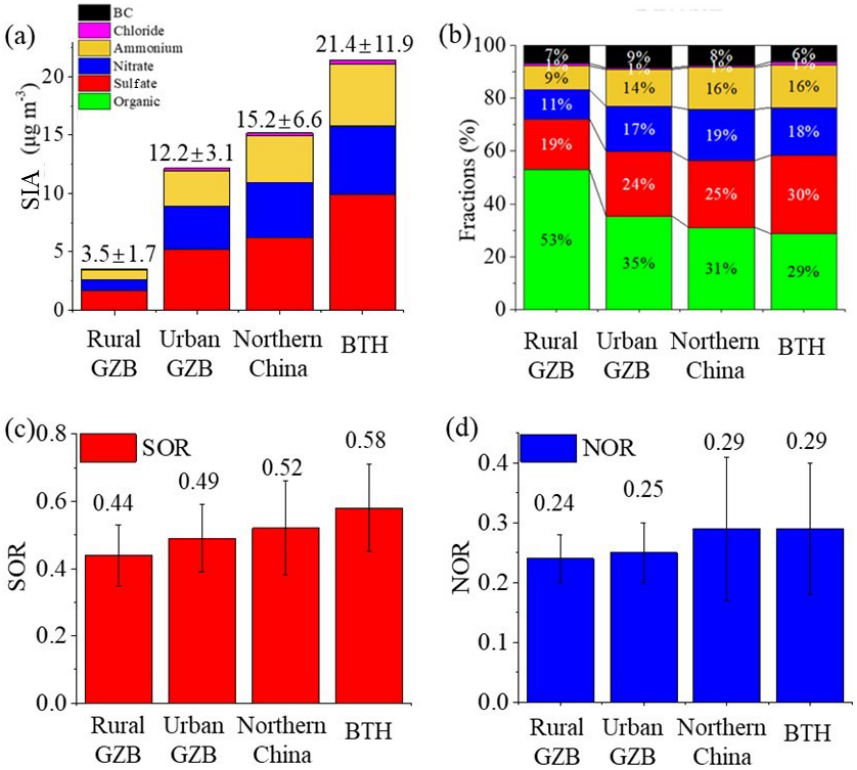
Figure 3. The comparison of (a) the mass concentration of SIA, (b) chemical fractions of PM 2 . 5 , (c) sulfur oxidation ratio (SOR) and (d) nitrogen oxidation ratio (NOR) in the four transport sectors.